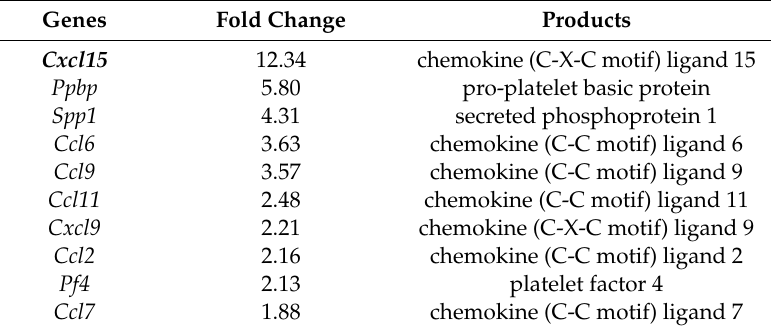
Table 2. Upregulated cytokine genes in mouse synovial sarcoma *.